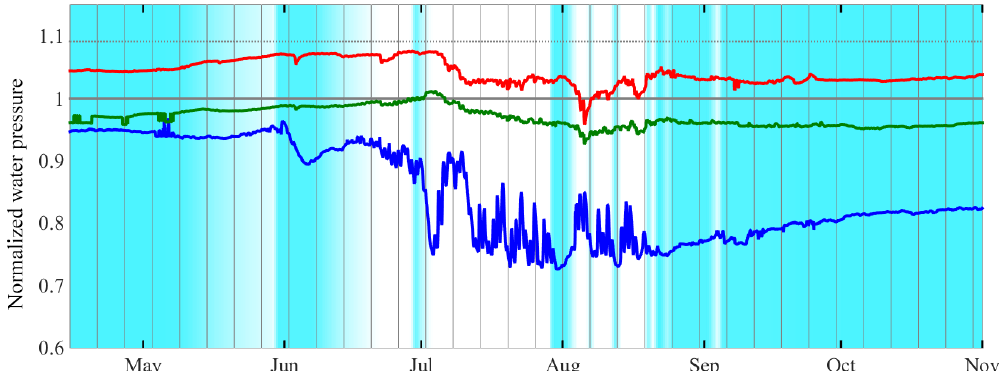
Figure 14. Glacier-wide spatially averaged mean water pressure values for three types of boreholes between 15 May and 1 November 2015. In blue, the mean of 171 boreholes that at some point in the 2015 melt season were hydraulically connected. In green, the mean of 78 boreholes that participated in mechanical clusters but were never hydraulically connected. In red, the mean of 33 boreholes that were at some point anti-correlated members of a hydraulic cluster but were never hydraulically connected. All water pressure values used to compute these means were normalized by the overburden pressure of each corresponding borehole. Light blue shading represents the approximate surface snow cover using the same colour scale as Fig. 10.